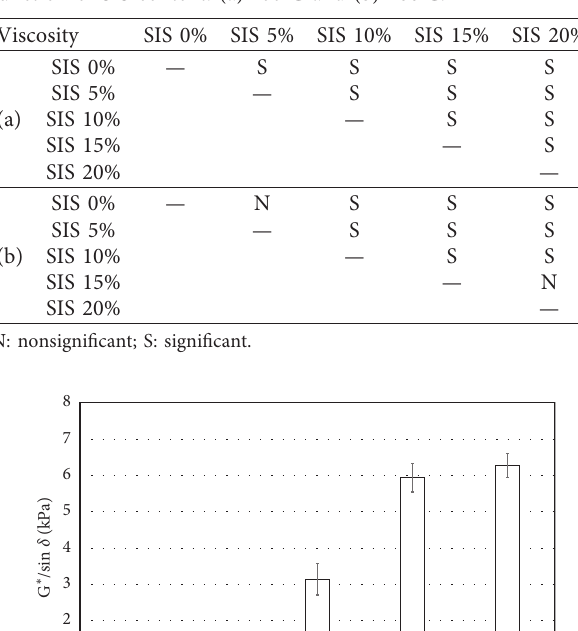
Figure 7: Viscosity of SIS binders at 135 ° C and 180 ° C. Table 2: Statistical analysis results of the viscosity value as a function of SIS content: (a) 135 ° C and (b) 180 ° C.